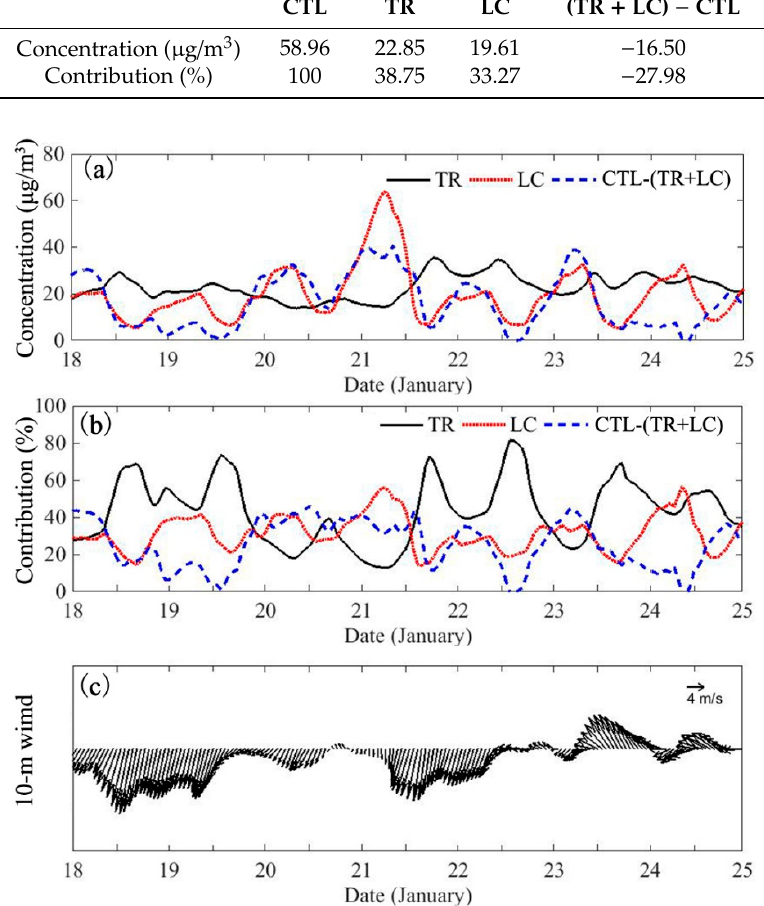
Figure 9. Time series of regional average PM 2.5 ( a ) concentration, ( b ) contribution rate, and ( c ) 10-m wind in CTL experiment. (extra-regional (TR), black solid line; local emission (LC), red dotted line; reverse of nonlinear response (CTL − (TR + LC)), blue dash line; 10-m wind, black vector).